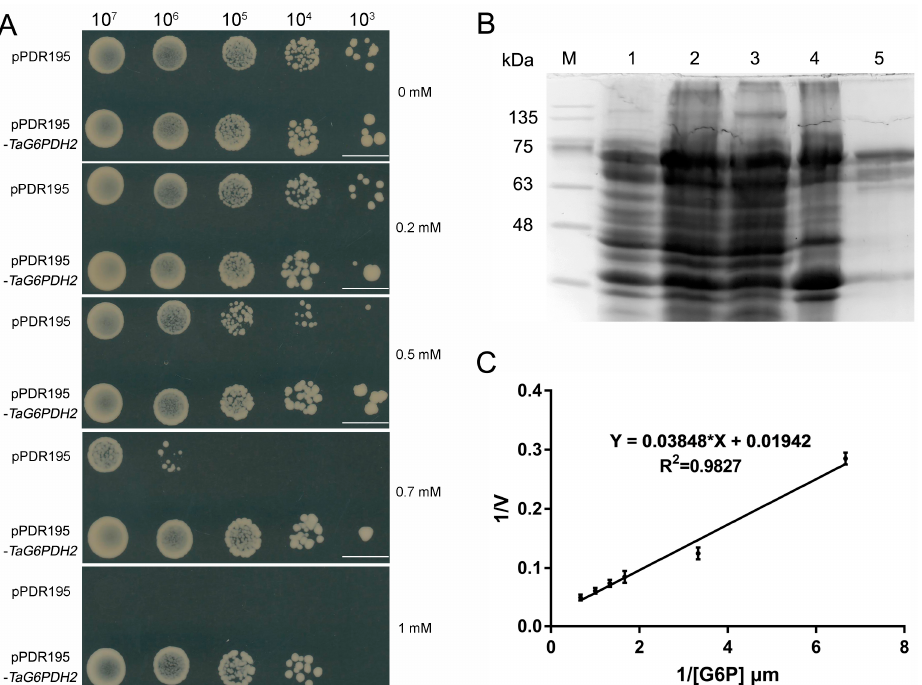
Figure 3. Heterologous expression of TaG6PDH2 in S. cerevisiae and E. coli . ( A ) Functional analysis of TaG6PDH2 in S. cerevisiae mutant strain YNL24C. Growth of YNL24C harboring either pDR195 or pDR195- TaG6PDH2 on SD/ − Ura plates containing different concentrations of H 2 O 2 . Scale bars, 1 cm. ( B , C ) Purification and enzymatic characterization of TaG6PDH2. ( B ) SDS-PAGE of samples at different purification stages of TaG6PDH2 in E. coli BL21 (DE3). Channel 1, control, uninduced E. coli cell lysates; channel 2, E. coli cell lysates induced by IPTG; channel 3, supernatant of bacterial lysate; channel 4, pellet of bacterial lysate; channel 5, purified fusion proteins; M, marker. ( C ) Linear regression equation presented by the double-reciprocal plot method (1/V vs. 1/[G6P]). Each point represents the average of three replicates with the standard error. * represents multiply.